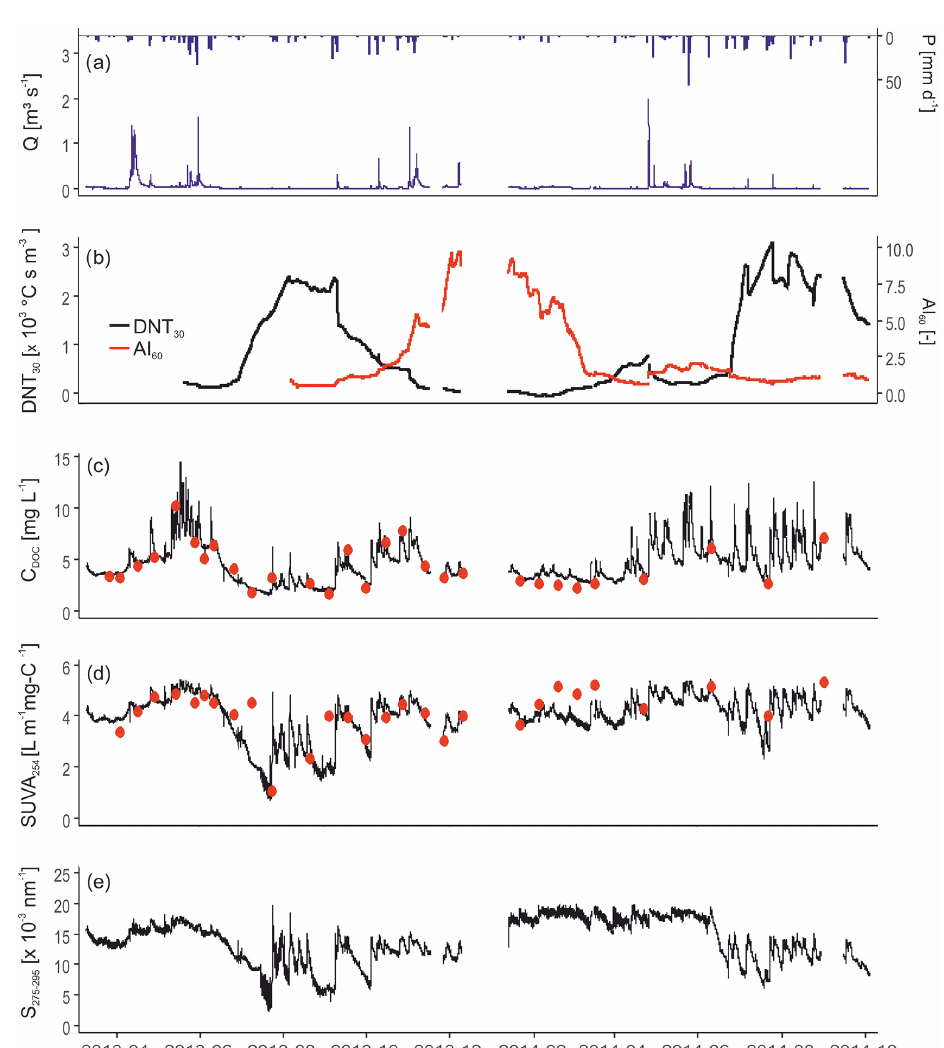
Figure 2. (a) Precipitation and discharge, (b) antecedent hydrometeorological conditions, (c) C DOC , (d) SUVA 254 and (e) S 275 − 295 over the entire measurement period. C DOC in (c) was fitted with PLSR to the measured grab samples (red dots). Grab samples (red dots) in the SUVA 254 values (d) were just used for